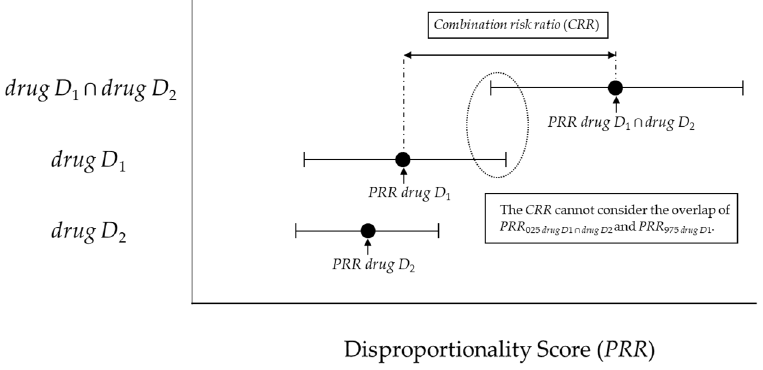
Figure 1. The association between the combination risk ratio ( CRR ) and disproportionality score. If such an overlap occurs, a risk signal may not be detected for concomitant